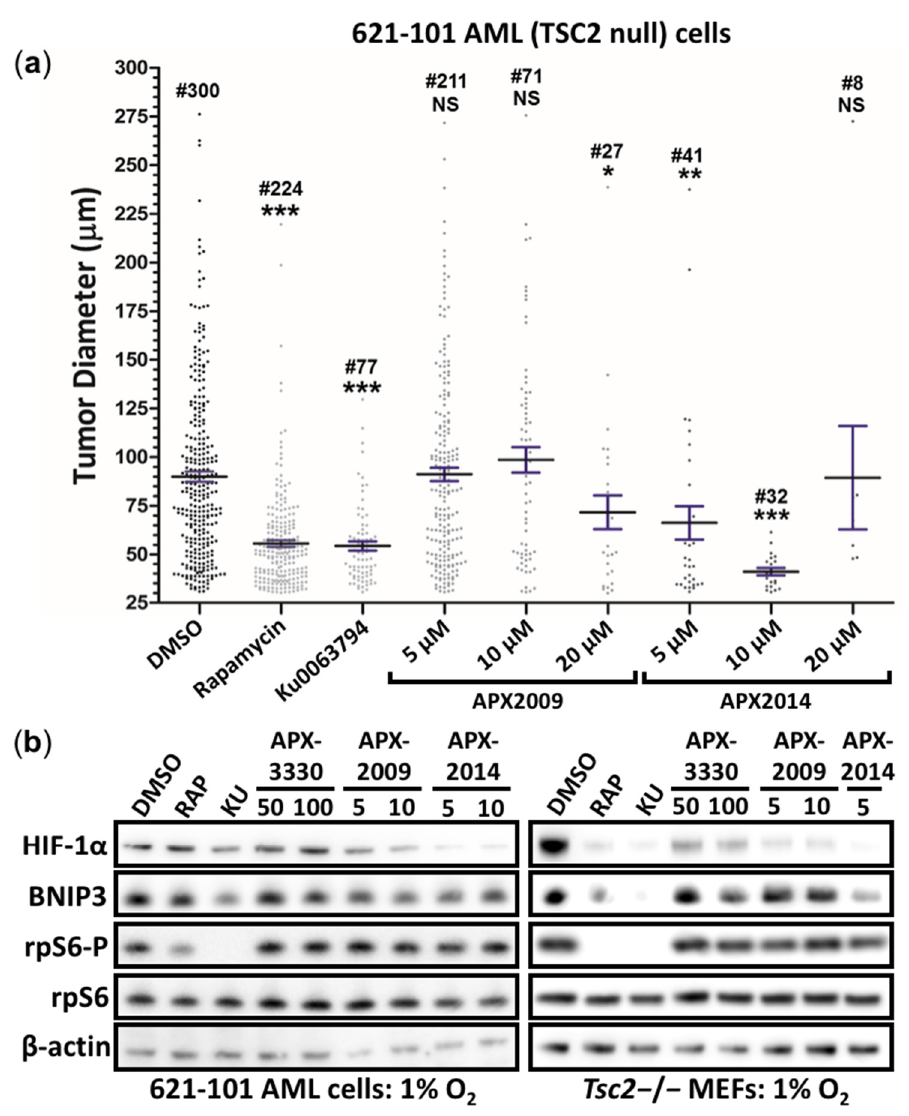
Figure 8. APX2009 and APX2014 show potency to inhibit in vitro tumor growth of 621-102 AML cells. ( a ) The 621-102 AML cells were subjected to in vitro tumor formation assays in the presence or absence of DMSO, 50 nM rapamycin, 1 µ M Ku0063794, APX2009 (5, 10, and 20 µ M), or APX2014 (5, 10, and 20 µ M), where indicated. Tumor diameters were quantified; the number of tumors (#) are indicated above each column (up to 100 tumors analyzed within each of three biological repeats). # refers to the number of tumors that were present. Error bars represent SEMs; * p < 0.05, ** p < 0.01, *** p < 0.001 when compared to the untreated DMSO control. ( b ) The 621-102 AML cells (left panel) or Tsc2 − / − MEFs (right panel) were treated with DMSO, 50 nM rapamycin, 1 µ M Ku-0063794 (KU), APX3330 (50 or 100 µ M), APX2009 (5 or 10 µ M), or APX2014 (5 or 10 µ M), where indicated, for 18 h under hypoxia (1% O 2 ). From prepared lysates, Western blots for total HIF-1 α , BNIP3, total and phosphorylated rpS6, and β -actin were carried out ( n =